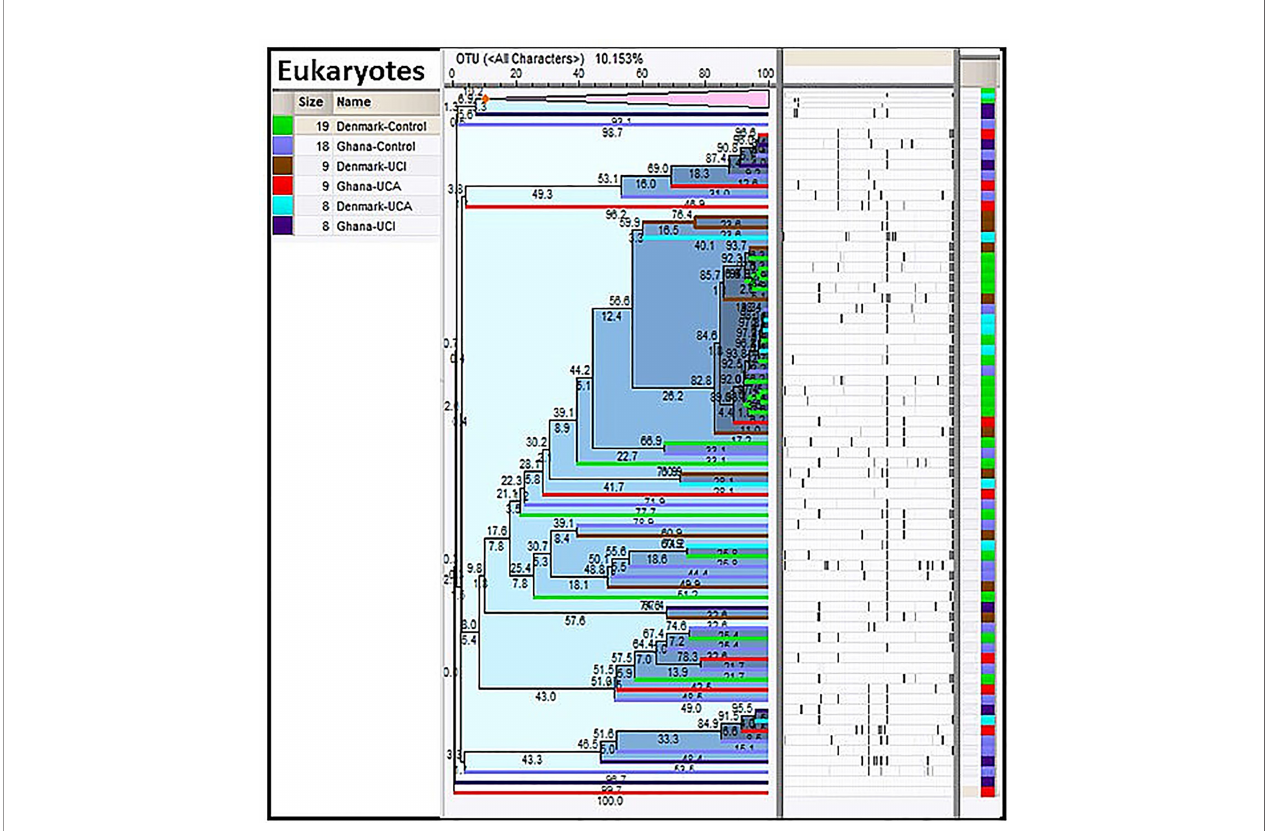
FIGURE 4 | Cluster analysis of eukaryotes in the study population. As it is shown, the Danish control group are clustered together in the center of the dendrogram with Danish UC patients, while the study groups from Ghana are spread all over the dendrogram.